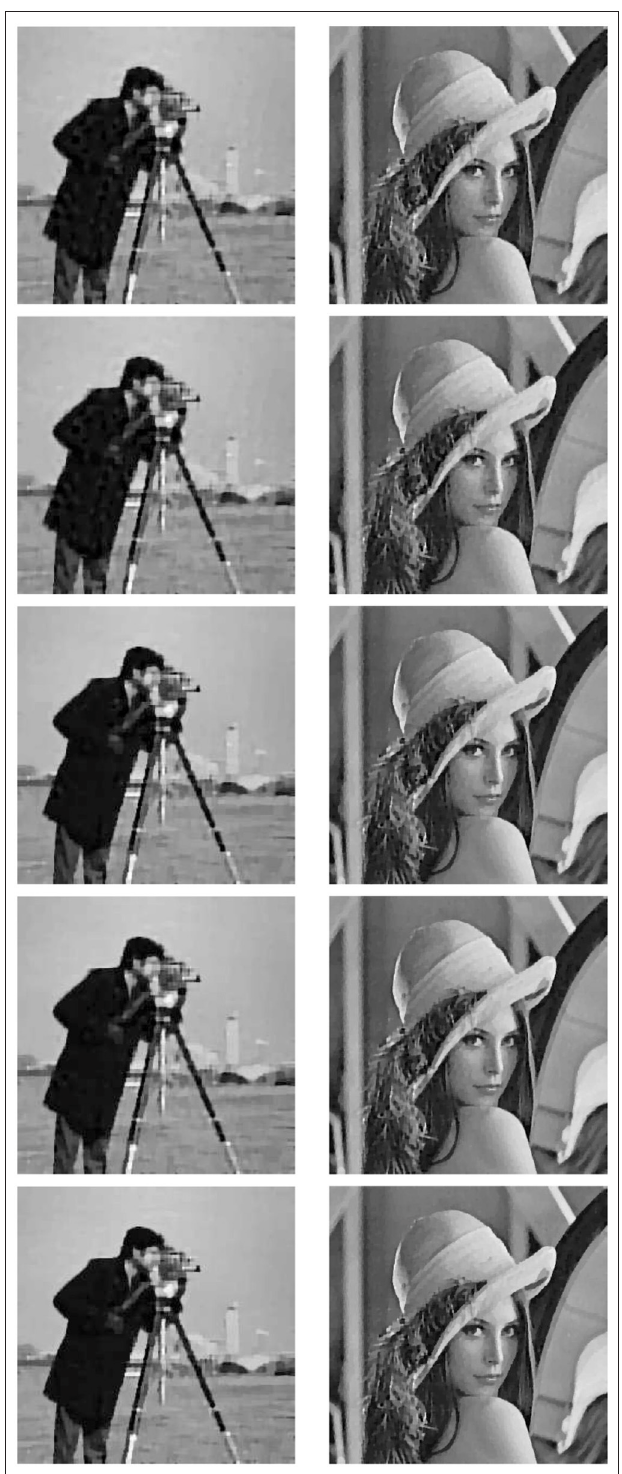
FIGURE 6 | Recovered images of “Cameraman” and “Lena” (from top row to bottom row) with the L1-TV model for images blurred by the (15 , 10)-GBM and corrupted by impulsive noise of level p = 0.5. Row 1: the CP; Row 2: the ZBO; Row 3: Algorithm 1; Row 4: Algorithm 2 with Equation (53); Row 5: Algorithm 2 with Equation